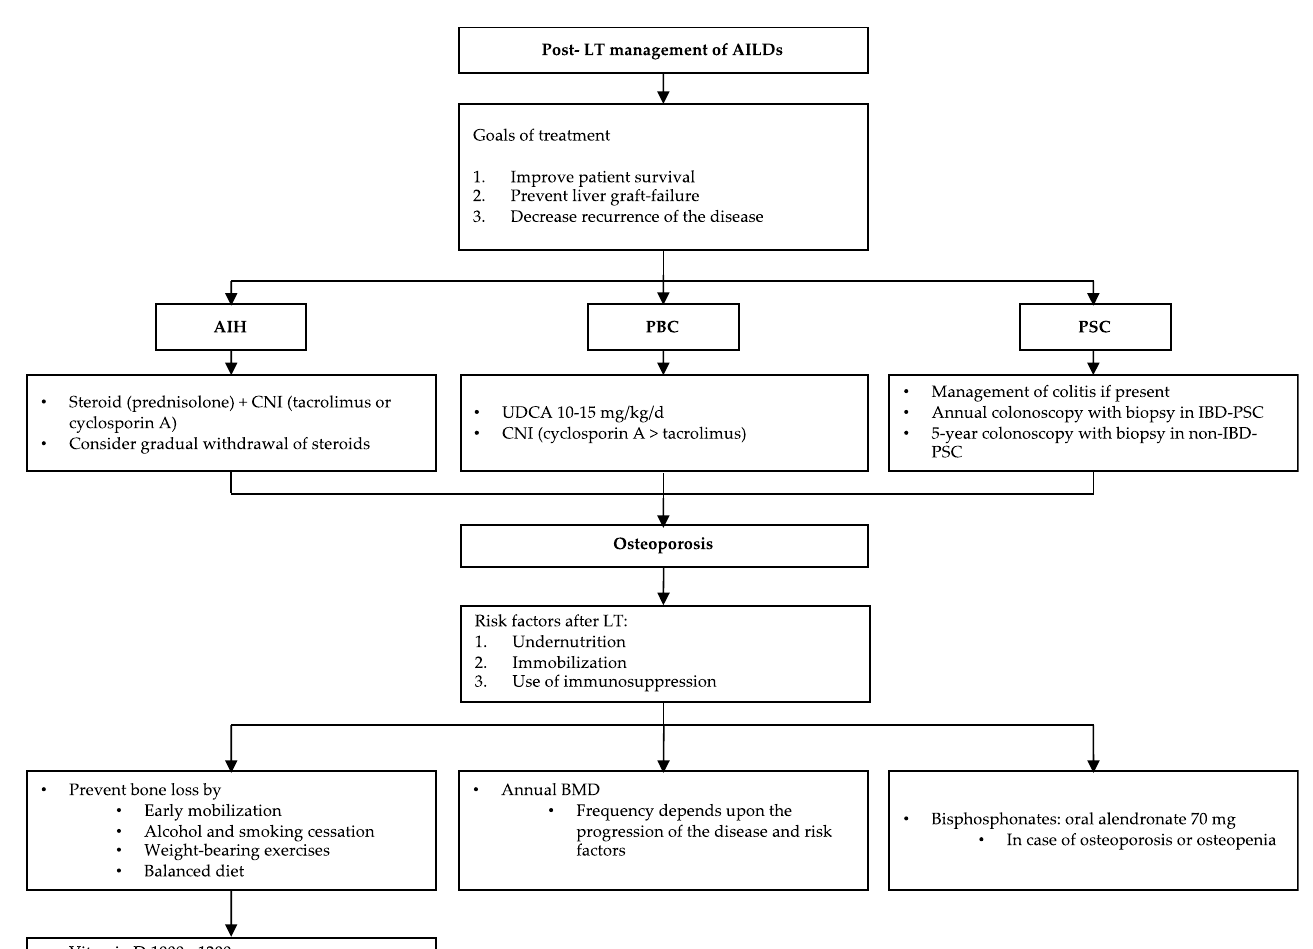
Figure 1. Post-liver transplant algorithm management. LT—liver transplant; AILD—autoimmune liver disease; AIH— autoimmune hepatitis; PBC—primary biliary cholangitis; PSC—primary sclerosing cholangitis; CNI—calcineurin inhibitors; UDCA—ursodeoxycholic acid; IBD—inflammatory bowel disease; BMD—bone mineral density.